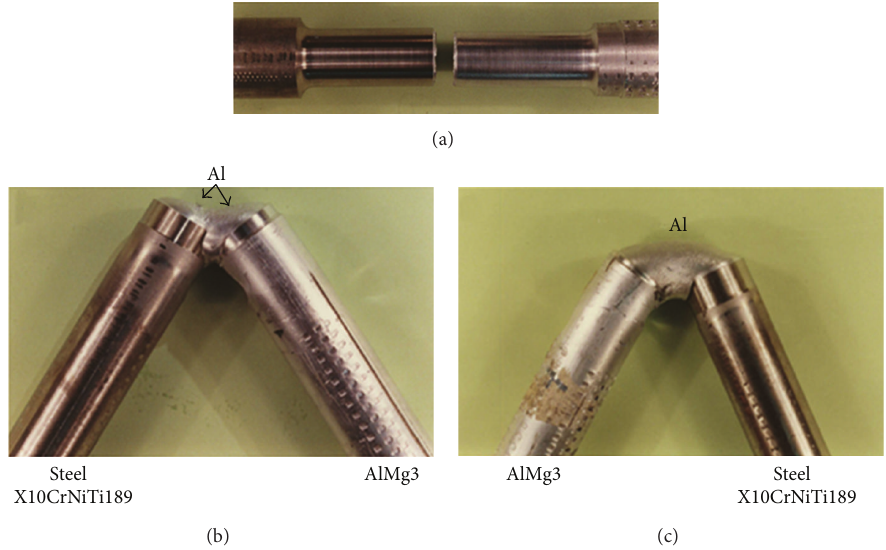
Figure 19: The view of a AlMg3 aluminium alloy-X10CrNiTi189 steel joint with an interlayer, with an addition of Al99,8 aluminium (thickness 8 mm) after the static tensile test (a), after the technological bending test (b), and after the technological bending test at the aluminium interlayer with a thickness of 18 mm (c) (according to [13]).